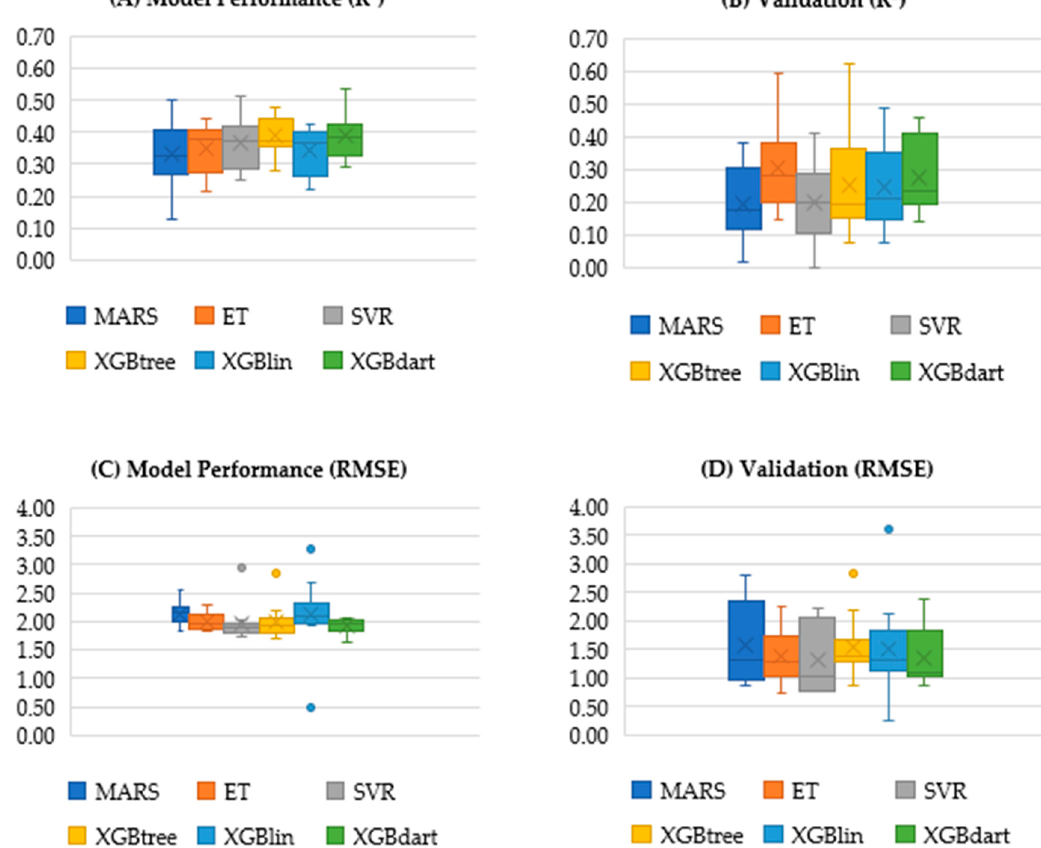
Figure 13. Machine learning model and validation performance using different input datasets.